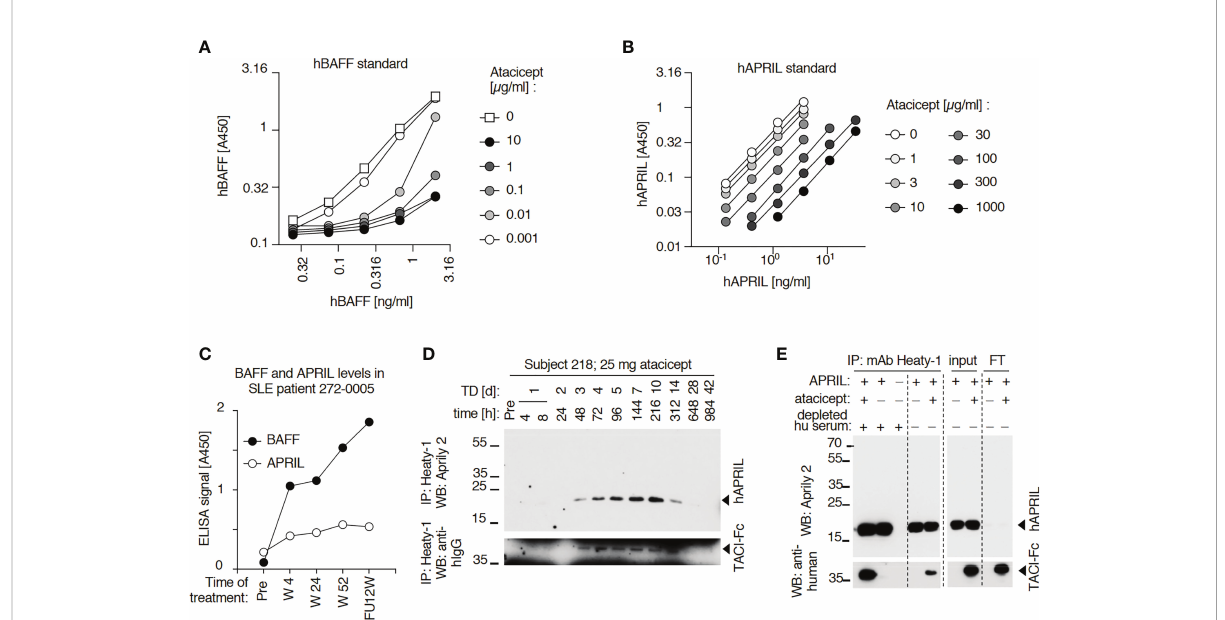
FIGURE 6 Detection of BAFF and APRIL in sera of an atacicept-treated SLE patient or a healthy subject. (A) Detection of titrated amounts of a hBAFF ELISA standard in the presence of increasing concentrations of atacicept. Experiment performed once with these concentrations, and once with higher atacicept concentrations (Figure 5A). (B) Detection of titrated amounts of hAPRIL ELISA standard in the presence of increasing concentrations of atacicept. Experiment performed twice. (C) BAFF and APRIL ELISA signals with 10 µl serum samples of an atacicept-treated SLE patient at different time points. Experiment was performed twice. (D) Endogenous APRIL was immunoprecipitated with beads coupled to anti-APRIL mAb Heaty-1 from 50 m l serum samples of healthy subject 208 who received 25 mg of atacicept. Immuno-precipitates were analyzed by SDS-PAGE and Western blot anti-APRIL. Experiment performed once for subject 208, and twice with subject 209 (Figure 5D). (E) Immunoprecipitation with anti-APRIL mAb Heaty-1 of recombinant APRIL (50 ng), in the presence or absence of atacicept (500 ng), in buffer or in normal human serum pre-depleted from endogenous APRIL. Immuno-precipitates were analyzed by SDS-PAGE and Western blot anti- APRIL to detect APRIL, followed by anti-human IgG to detect atacicept. Experiment performed 3